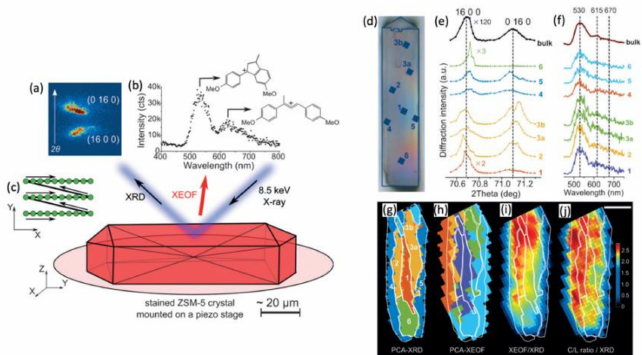
Figure 10. Combined µ -XRD and µ -XEOF (X-ray excited optical fluorescence) experiment when measuring a zeolite micro-crystal. ( a ) A 2D image of the detector with the two diffraction peaks. ( b ) XEOF spectrum, detected with a UV/Vis spectrometer. ( c ) An x-y scan to acquire the spatially resolved µ -XRD and µ -XEOF intensity maps. ( d ) Optical micrograph of the sample. ( e ) Diffractograms and ( f ) XEOF spectra, measured at different positions on the sample. ( g – j ) Principal component analysis of µ -XRD and µ -XEOF measurements and the combination of measurements. The scale bar corresponds to 20 µ m [106]. Reprinted from